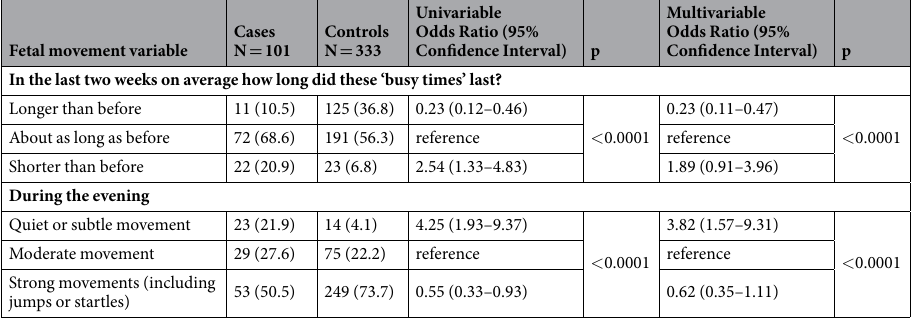
Table 4. Fetal movement strength and pattern and odds of late stillbirth. Data are n (%). Adjusted for; parity, employment, body mass index, infant sex, and gestation. All fetal movement variables in table are included in